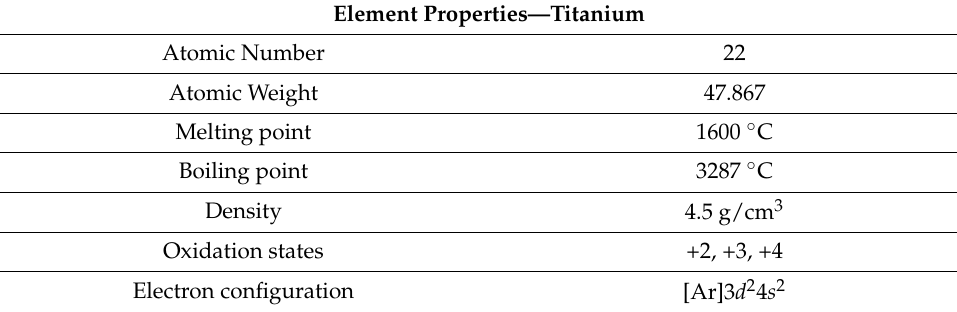
Figure 2. ( a ) Titanium Sponge ( b ) TMC Engine blade ring of aircraft [29]. Table 1. Physical properties of Titanium [31].